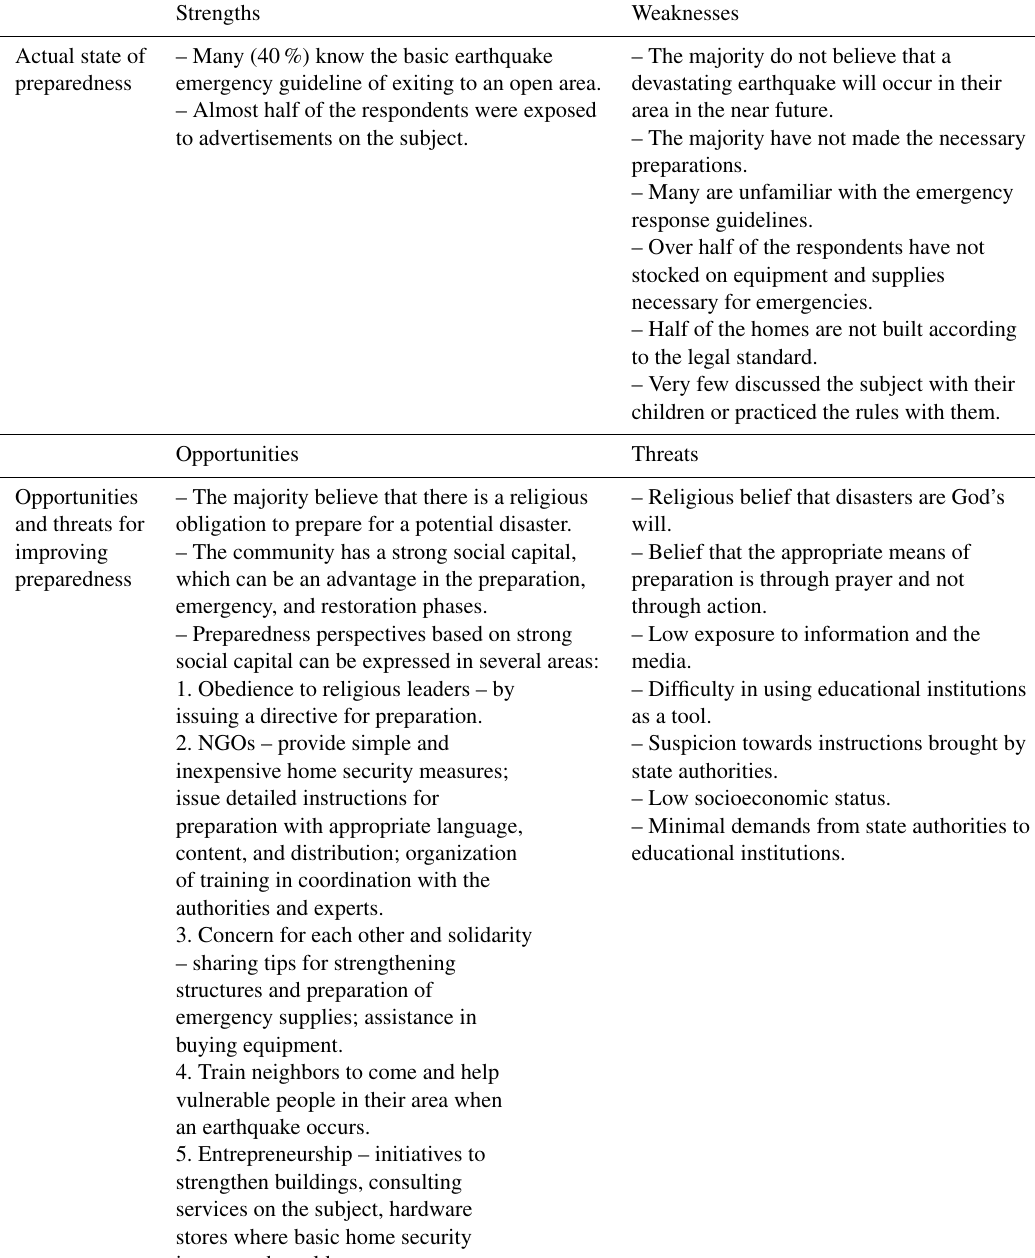
Table 3. SWOT (strengths, weaknesses, opportunities, threats) analysis summarizing the state of earthquake preparedness in the ultra- Orthodox society and characteristics that may hinder or promote